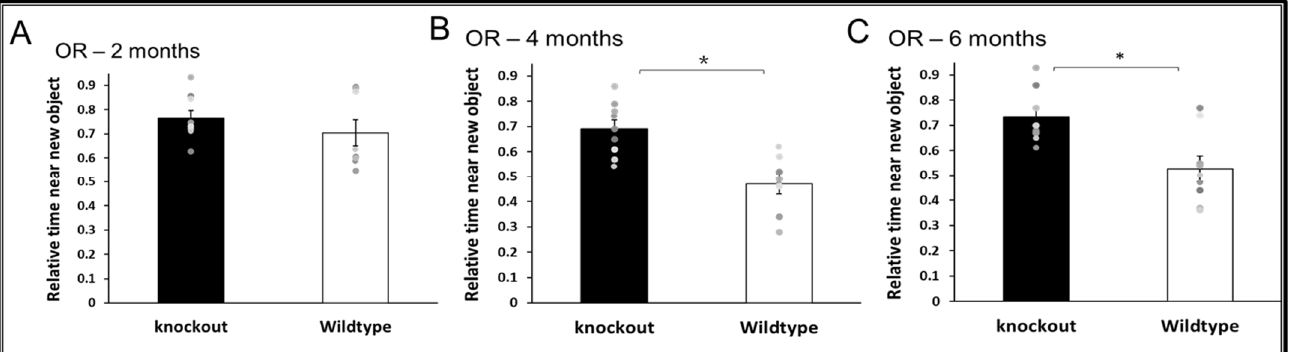
Figure 4 . The effect of CD24 knockout on long term episodic memory. Abolition of CD24 increased long term episodic memory in the novel object recognition test at 4 months ( B ) and 6 months ( C ). No difference was observed at 2 months ( A ). n = 8 mice per group. * indicated p < 0.05.